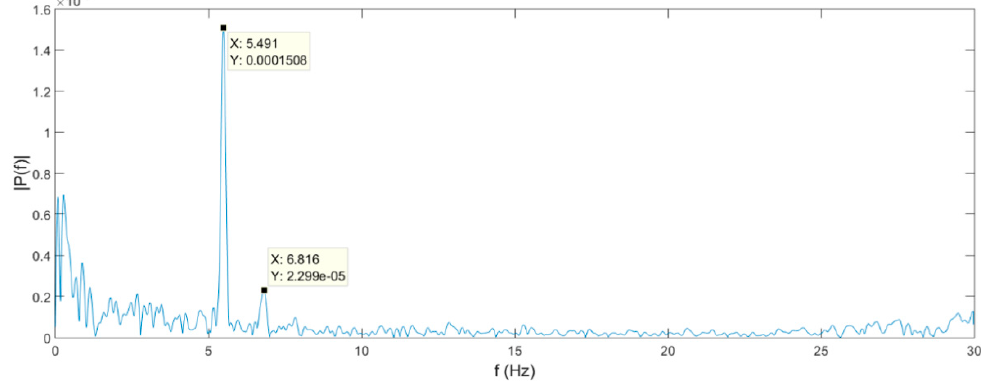
Figure 17. Amplitude spectrum of vertical component and detected first and second frequencies by IATS prototype (excitation by train passing at 60 km/h).